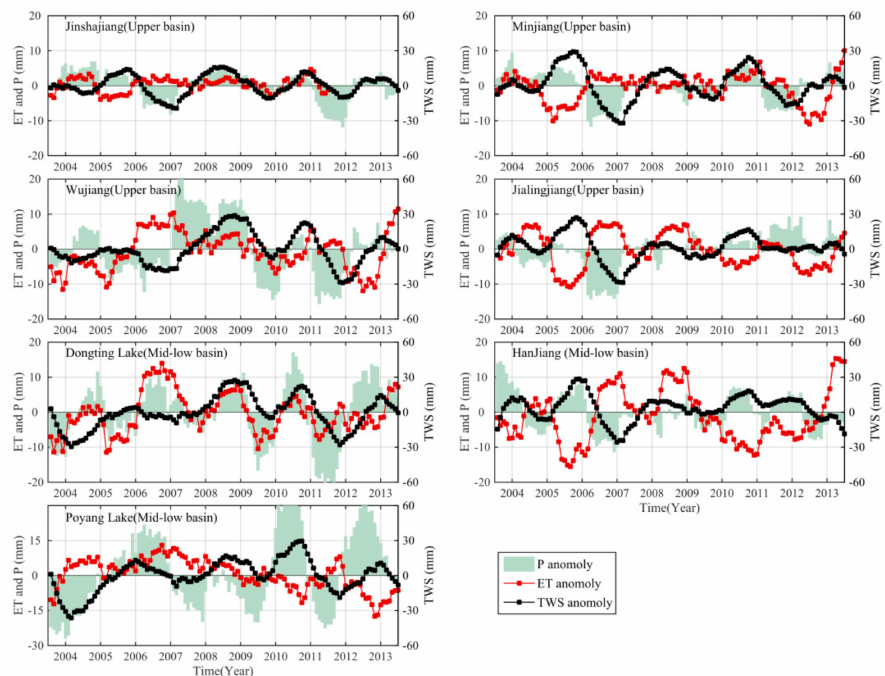
Figure 6. The non-seasonal TWS anomaly from GRACE, ET from the water balance method, and precipitation from the Global Precipitation Climatology Project (GPCP) dataset 2003–2013, smoothed using the 13-month moving average